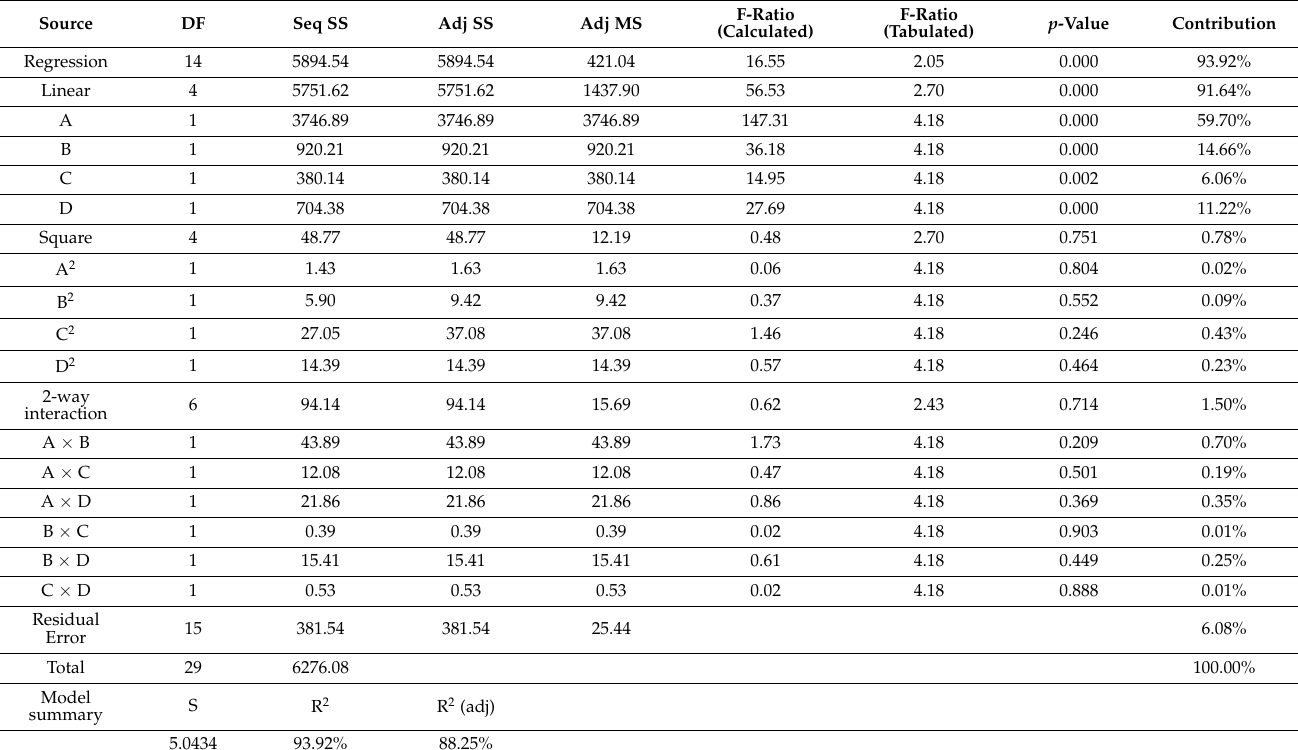
Table 11. ANOVA for drilling temperature of MoS 2 -loaded CEC.